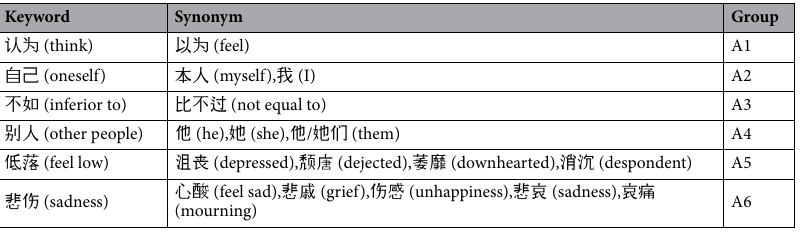
Table 1. Attributes of inferiority